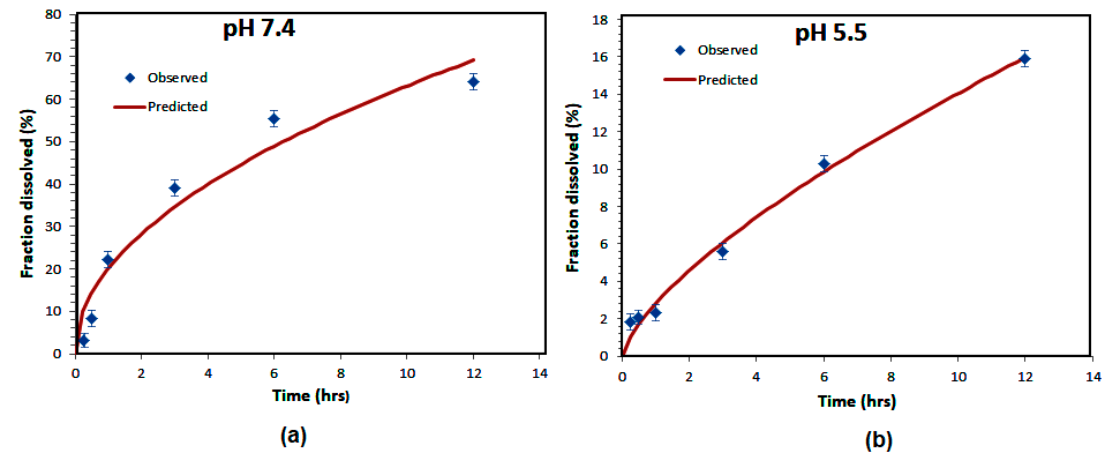
Figure 6. Korsmayer–Peppas kinetic models of Amp B release from polymeric nanoparticles at pH = 7.4 ( a ) and pH = 5.5 values ( b ).